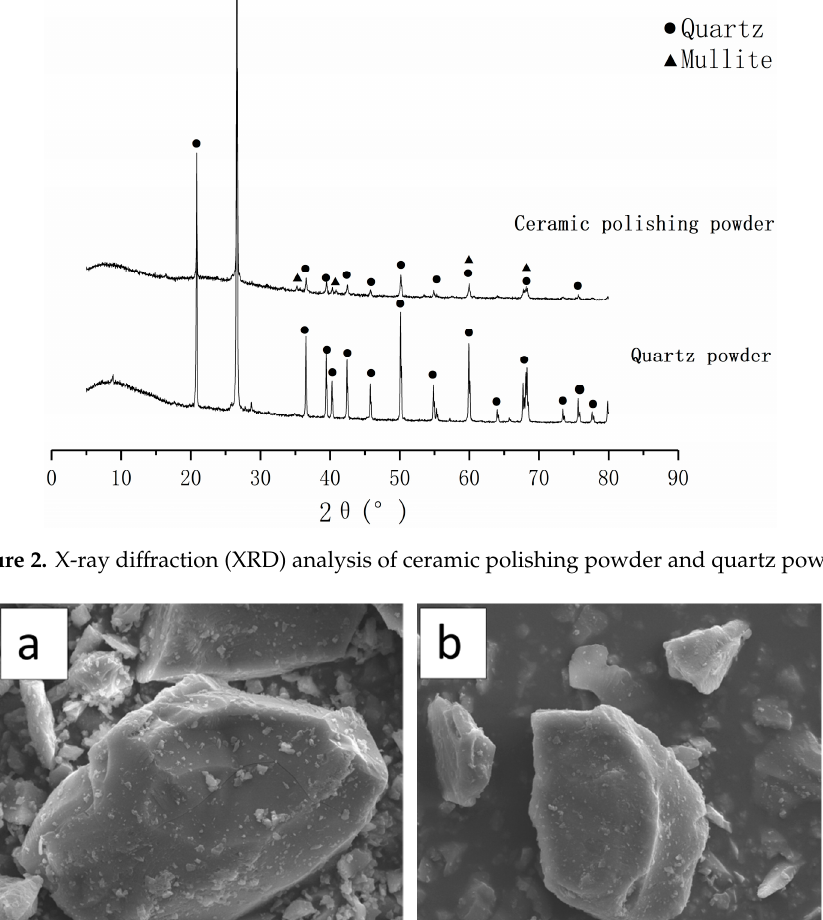
Figure 3. Morphology of quartz ( a ) and PP ( b ).